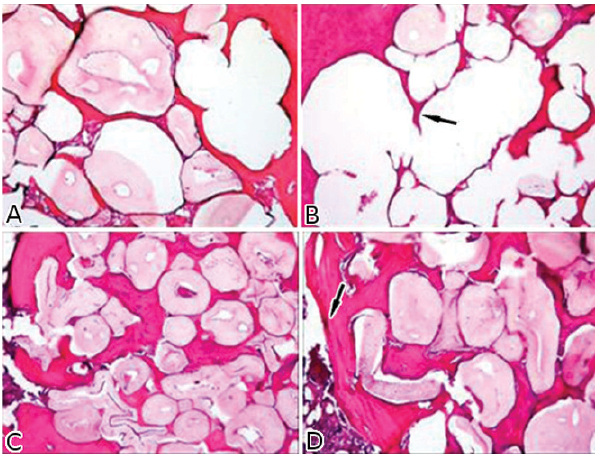
Figure 3 - Histology of tibias implanted with PLLA/PEO that were A) vancomycin-loaded or B) vancomycin-unloaded after 4 weeks, showing thin trabecular bone (arrow); and PLLA/PEO that were C) vancomycin-loaded or D) vancomycin-unloaded during a 32- week period, showing massive bone formation surrounding the microspheres with evident maturation and the presence of lamellar bone (arrow) (Original H&E 10 6